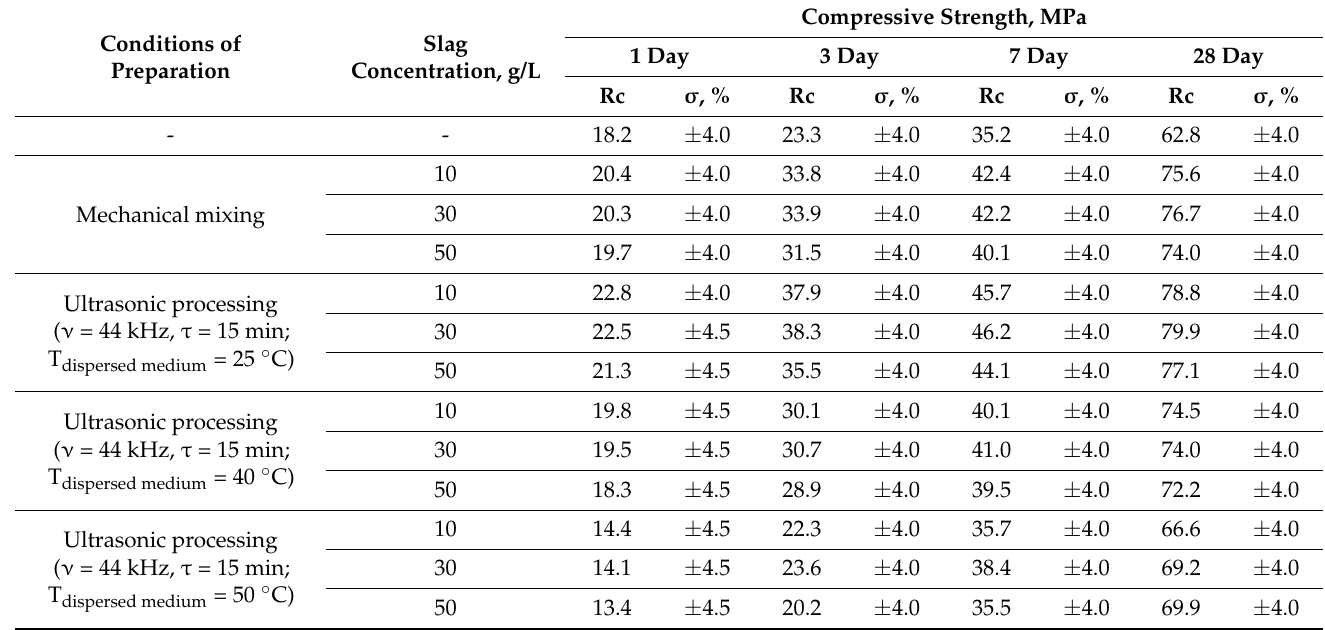
Table 9. Comparison of strength characteristics of samples with slag suspension under different conditions of ultrasonic processing.